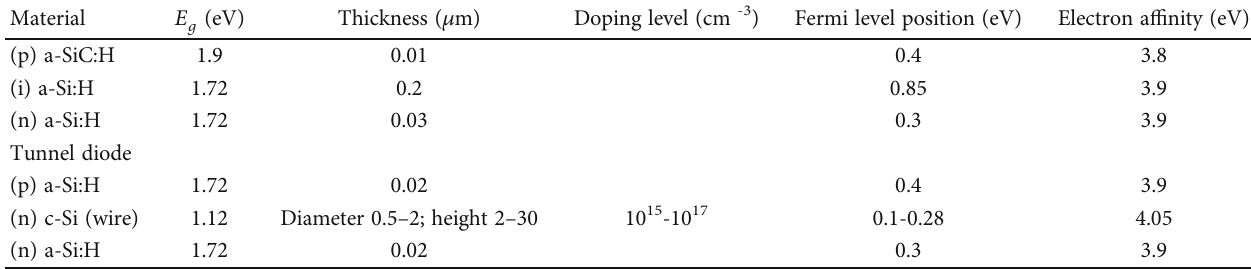
Table 1: Parameters of the layers of the tandem a-Si:H/c-Si SC.